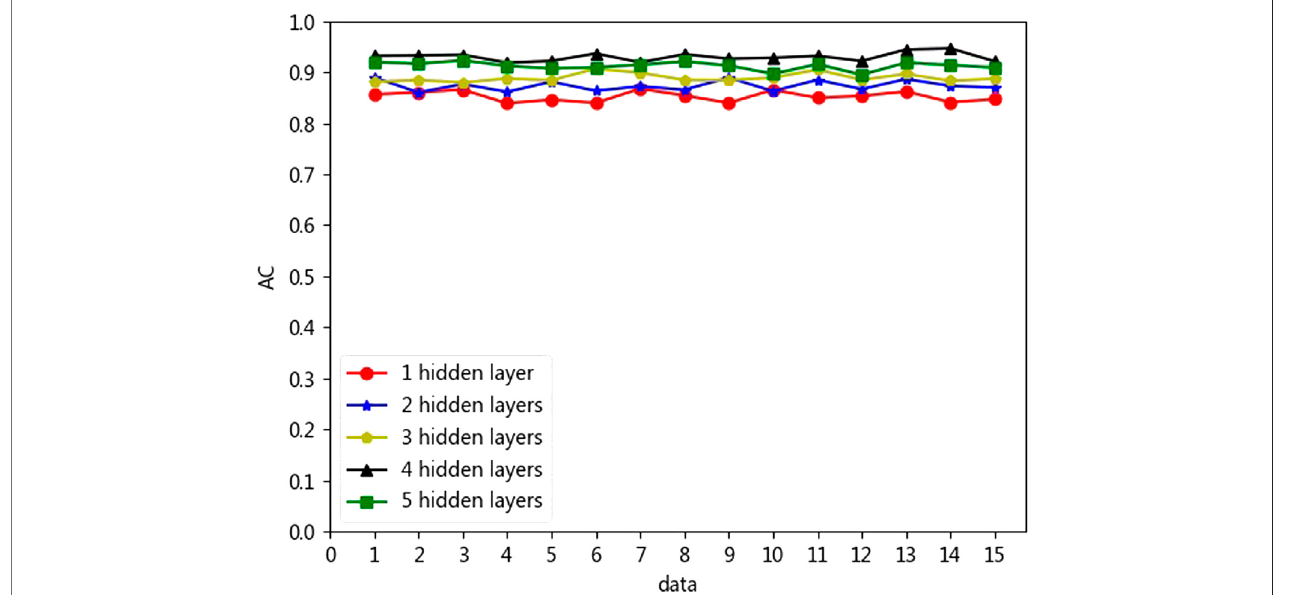
FIGURE 6 | Detection results with different hidden layers of attack gene extraction.